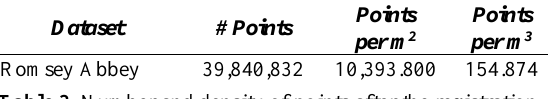
Table 3. Number and density of points after the